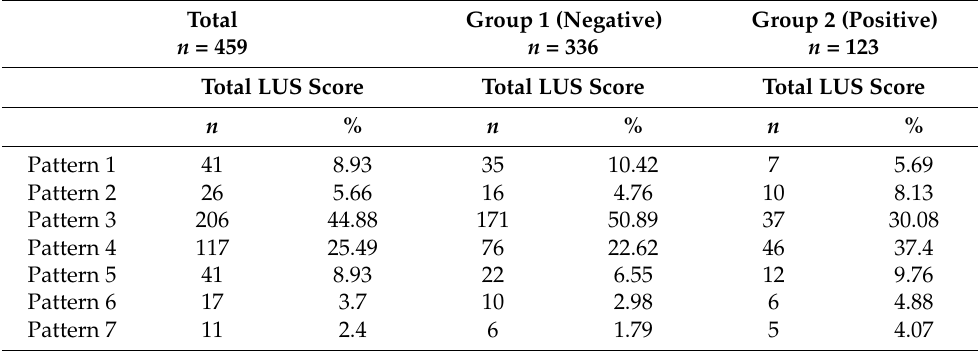
Table 2. Pattern distribution and